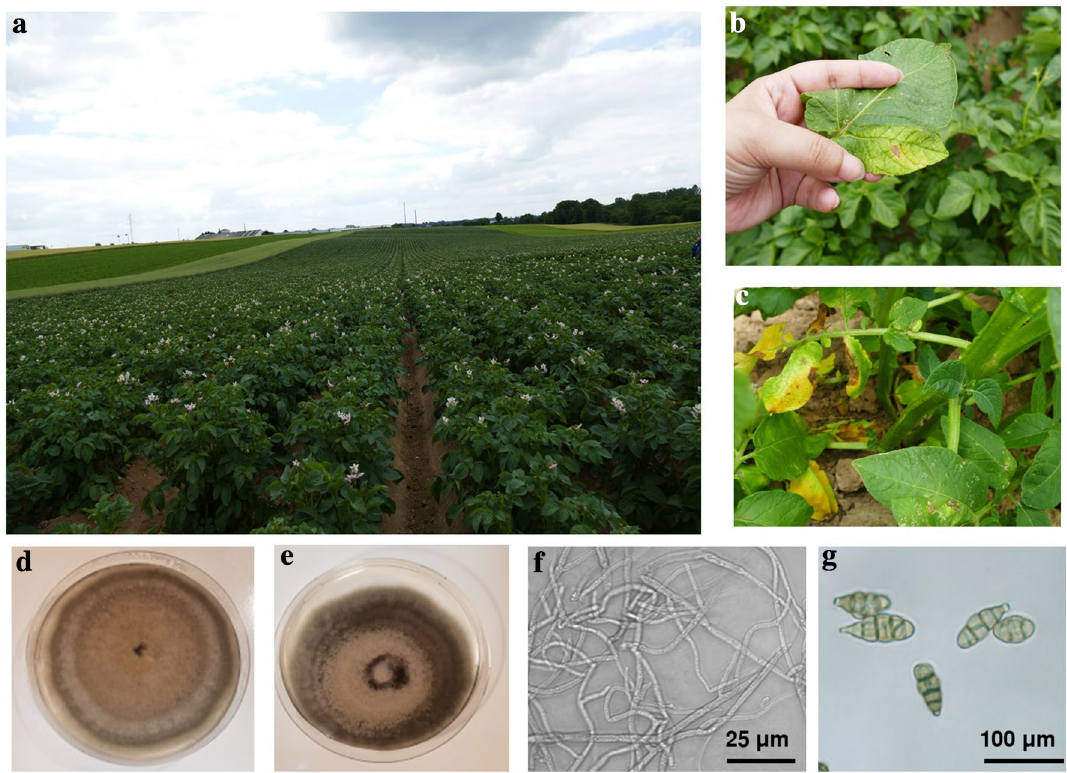
Figure 1. ( a ) Photograph showing the sampling area of a potato field infected with brown spot disease, ( b , c ) development of brown spot symptoms on potato leaves with small black to brown lesions and yellowing of leaves, ( d , e ) morphological characteristics of A. alternata on PDA ( d ) and V8 agar ( e ) after 7 days of incubation at 26 ± 1 °C, ( f ) mycelium of A. alternata , ( g ) spores of A. alternata .